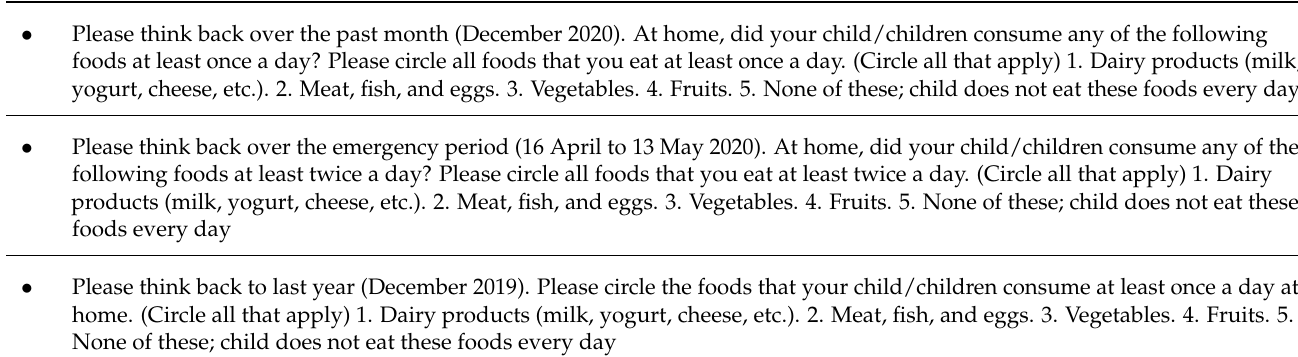
Table 1. Questionnaire to assess the prevalence of eating selected food groups in 10–14-year-old schoolchildren in Japan. • Please think back over the past month (December 2020). At home, did your child/children consume any of the